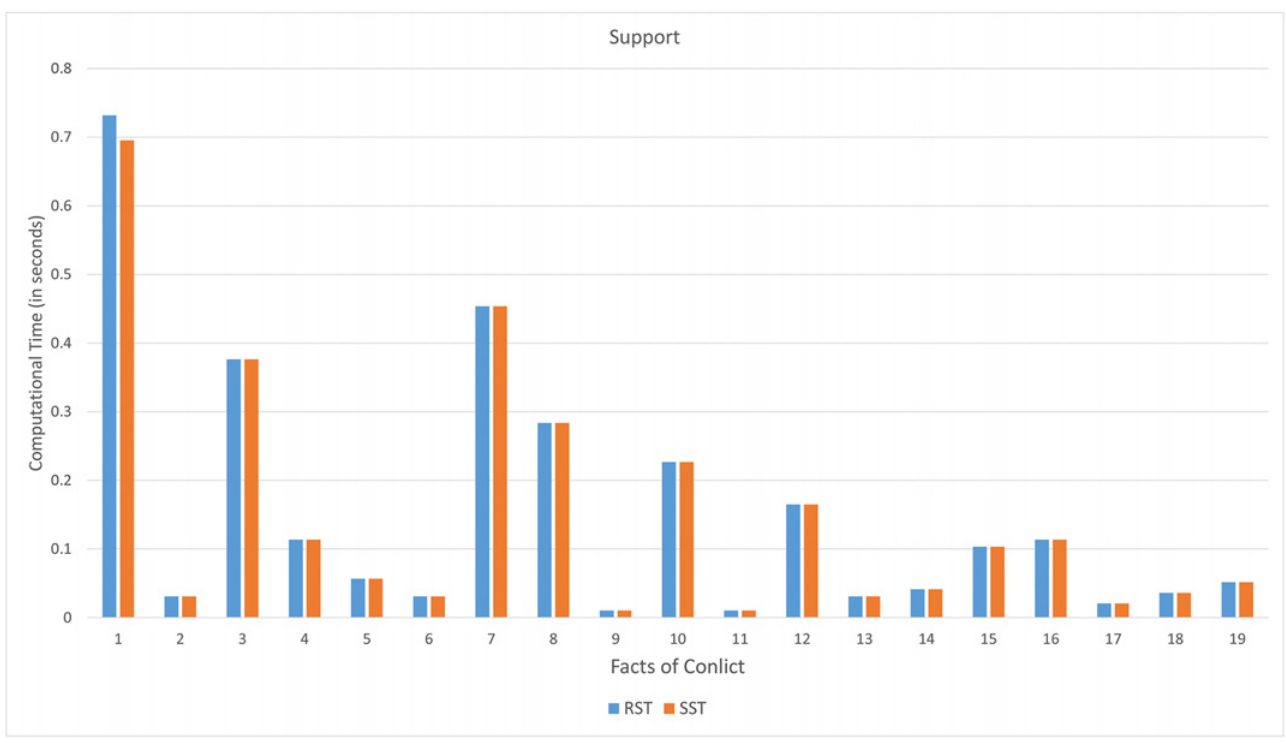
Fig 12. Computational time on computing supports.